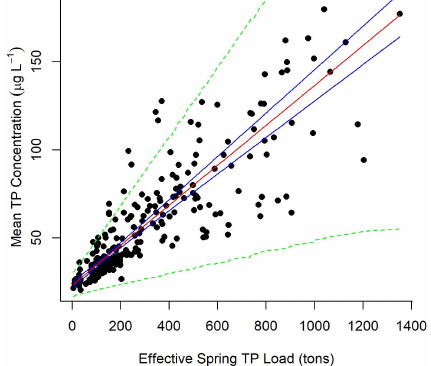
Figure 4. Mean concentration at the observed nodes for each year was modeled as a function of the relative Maumee River spring TP load (mean concentration = 23.1 ( ± 1 . 75, 95%CI) + 0.11 ( ± 0 . 01, 95%CI) × effective load), where variance in concentration increased linearly with effective load. Effective load was defined by multiplying the normalized river impact generated by experimen- tally tracing the Maumee River’s impact on Lake Erie nodes annu- ally; 95% predictive intervals of the data (green dotted lines) and 95% credible intervals of the linear relationship (blue solid lines) were generated from the model